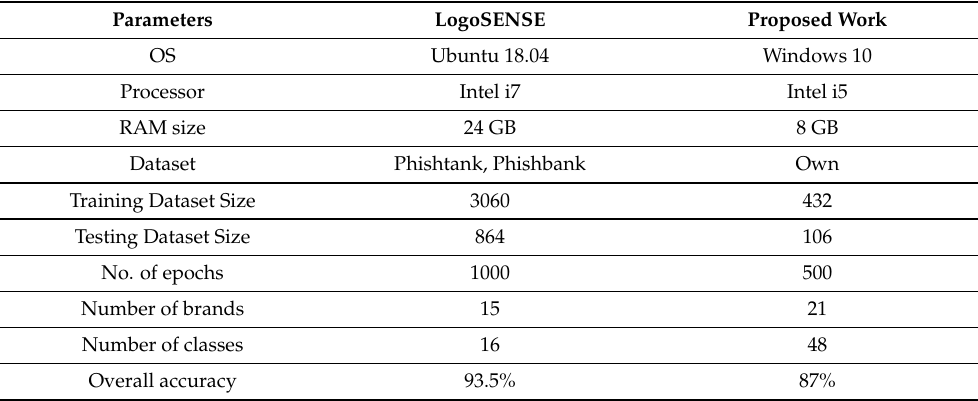
Table 4. Comparison of the proposed work with LogoSENSE